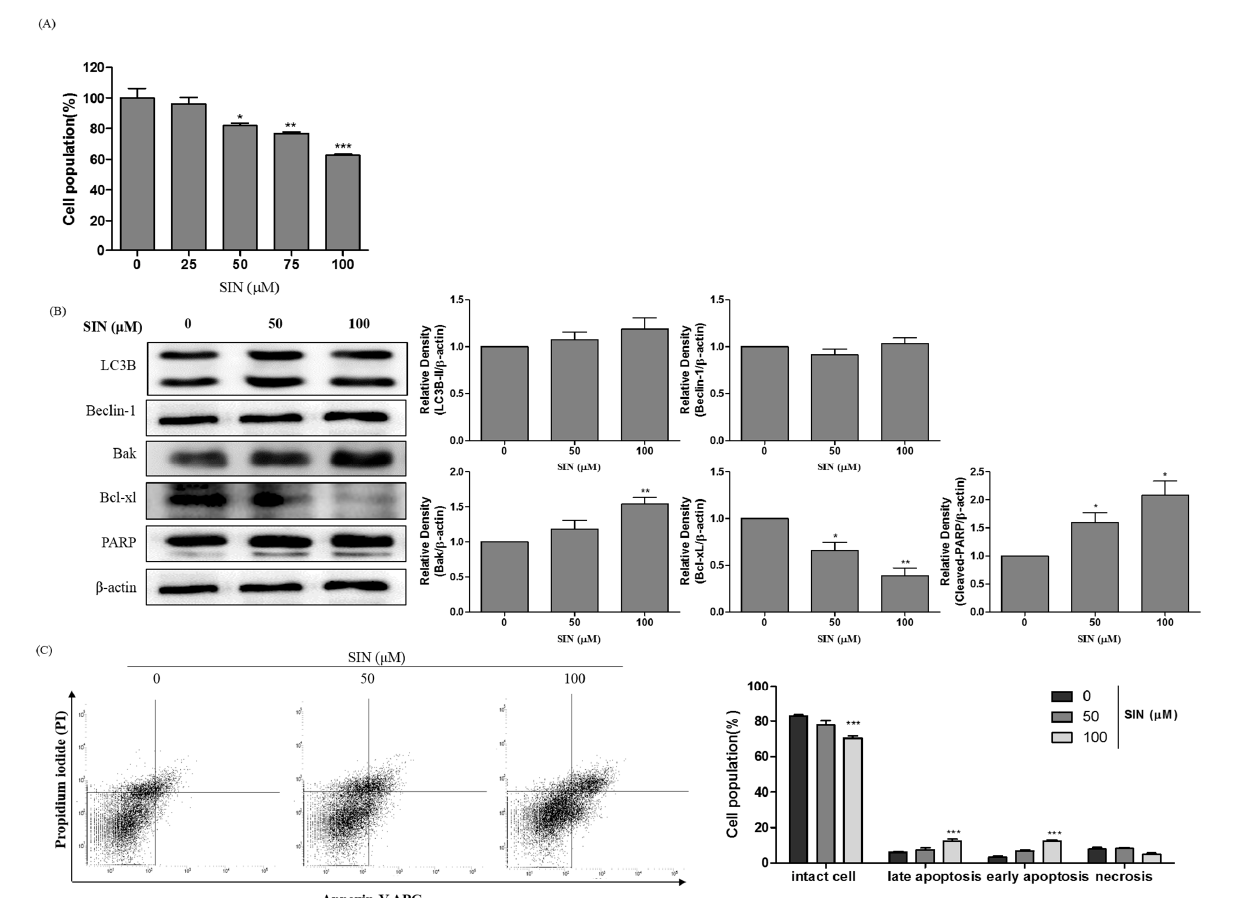
Figure 5. SIN increases apoptosis in p53-null Hep3B cells. ( A ) Hep3B cells were treated with SIN (0, 25, 50, 75, and 100 µ M) for 48 h, and the cell viability was determined by the MTT assay. ( B ) Hep3B cells were exposed to SIN for 48 h. Total lysates were analyzed by immunoblotting. β -Actin was used as a loading control, and the quantified expressions by Image J software were plotted in the bar graphs. ( C ) Apoptosis was identified by annexin V-propidium iodide (PI) staining and analyzed by flow cytometry. The data are presented as the mean ± SEM of three independent experiments. The results are presented as a percentage compared to vehicle control. * p < 0.05 vs. Hep3B cell vehicle control; ** p < 0.01 vs. Hep3B cell vehicle control; *** p < 0.001 vs. Hep3B cell vehicle